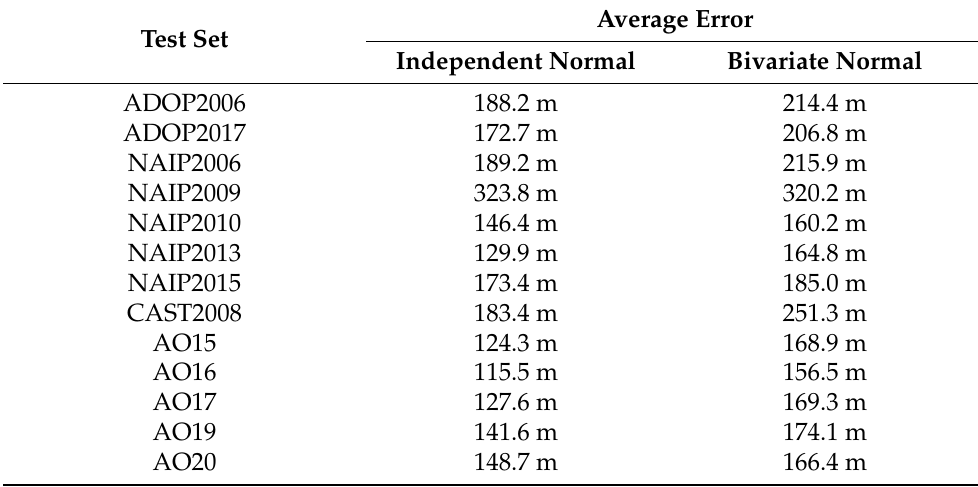
Table 5. Xception results on different holdout sets. Models were trained for 500 epochs. Error is reported in Euclidean